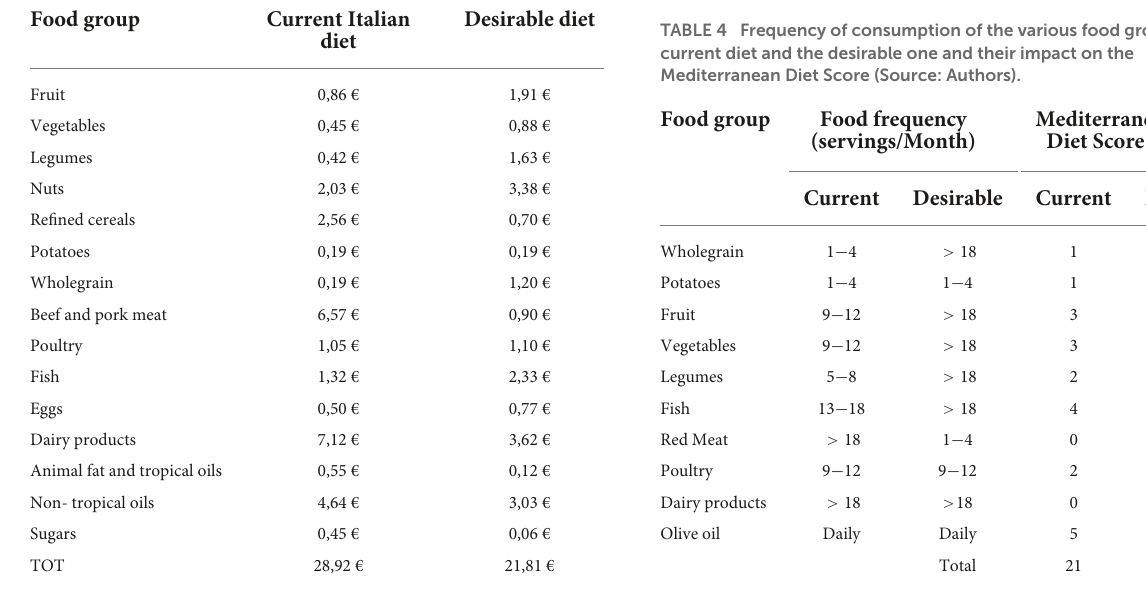
Italian adult population would experience a 21% reduction in the rate of